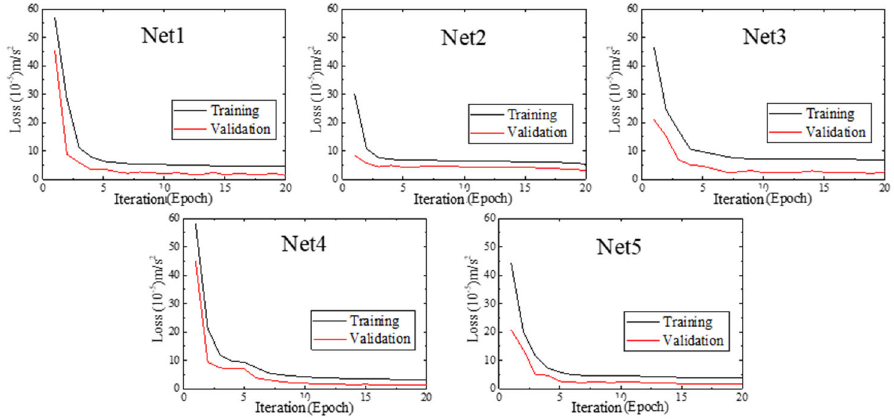
Figure 6. The training processes of built networks.